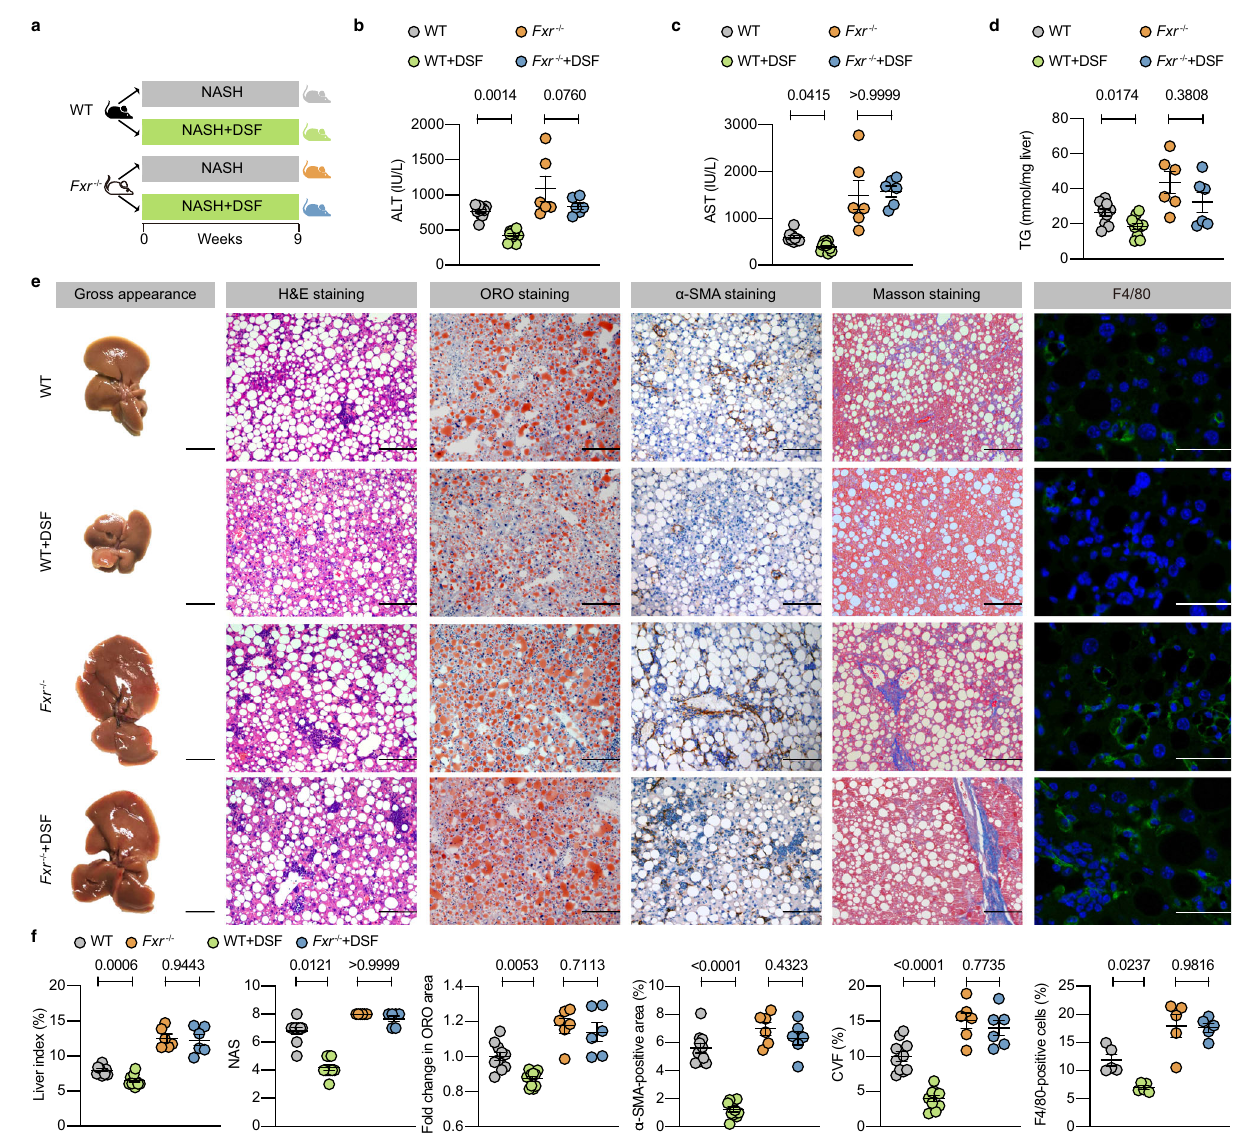
Fig. 5 | DSF depends on bile acid-induced hepatic FXR signaling activation to ameliorate NASH. a Experimental design. WT and Fxr − / − mice were randomized into 4 groups (WT, WT+DSF, Fxr − / − and Fxr − / − +DSF) under a CDAHFD or CDAHFD+DSF, respectively for 9 weeks. b – d Serum ALT and AST; hepatic TG. e Representative images of gross appearance of the liver histology (1cm) and photomicrographs of fi xed liver sections after staining with H&E (200 μ m),